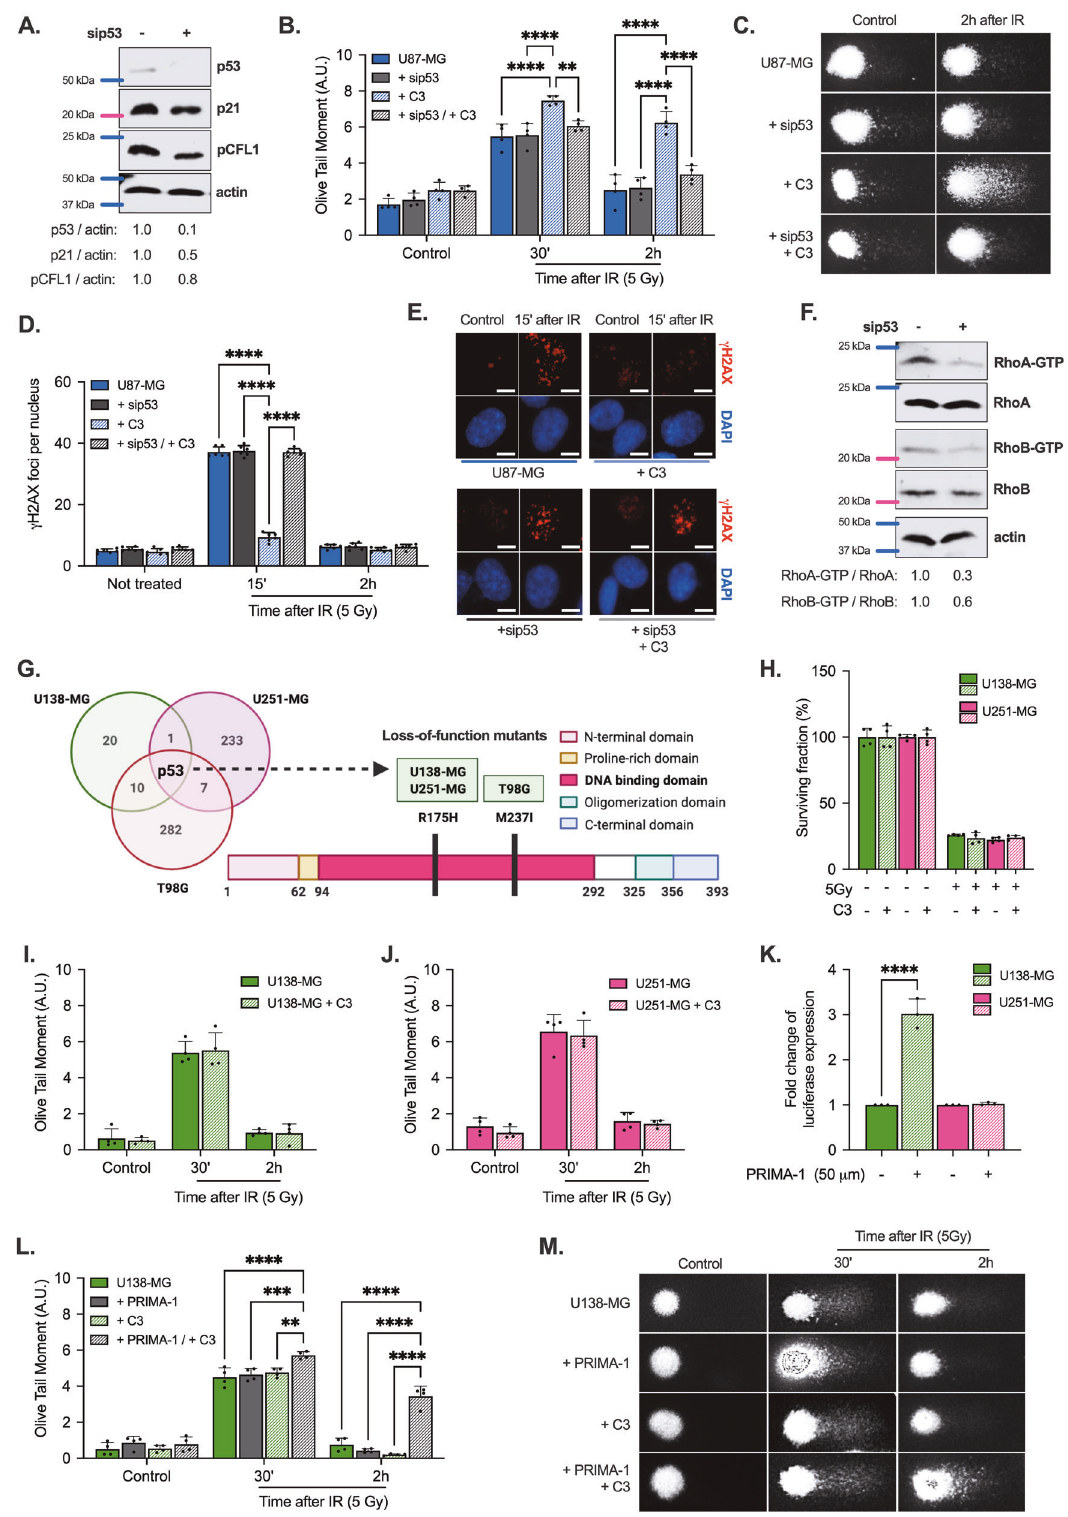
strategy to modulate Rho pathway activity through the starvation of U87-MG cells in serum-free medium (SFM) with subsequent addition of high levels of serum (Fig. S6B). Starvation in SFM for 48 h decreased RhoA and RhoB activity, as well as CFL1 phosphorylation, while stimulation with a 30% FBS pulse for 30 min strongly increased Cell Death and Disease (2023)